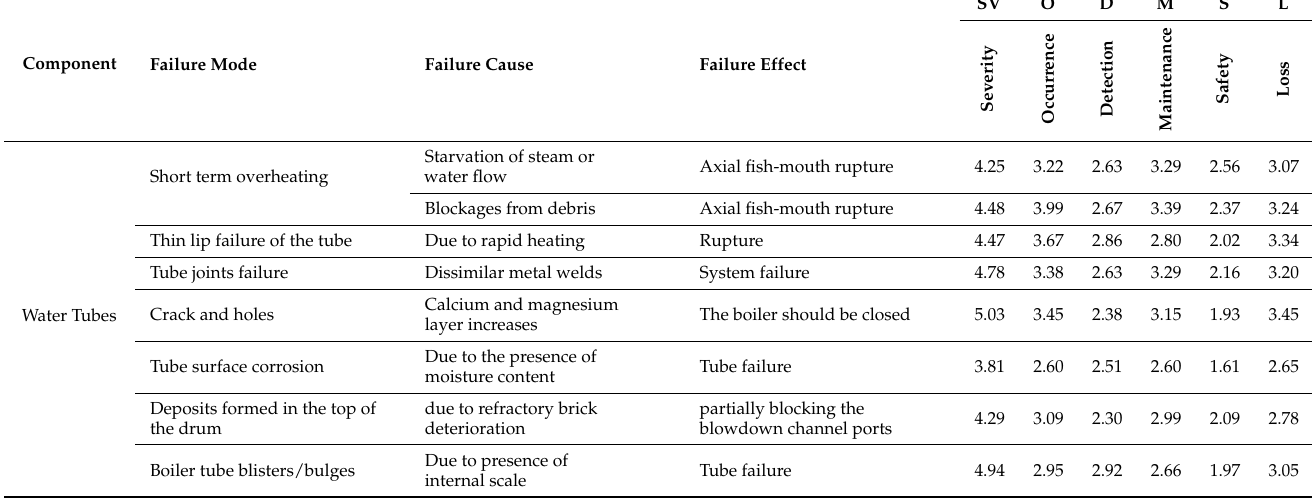
Table 9. Decision matrix A for